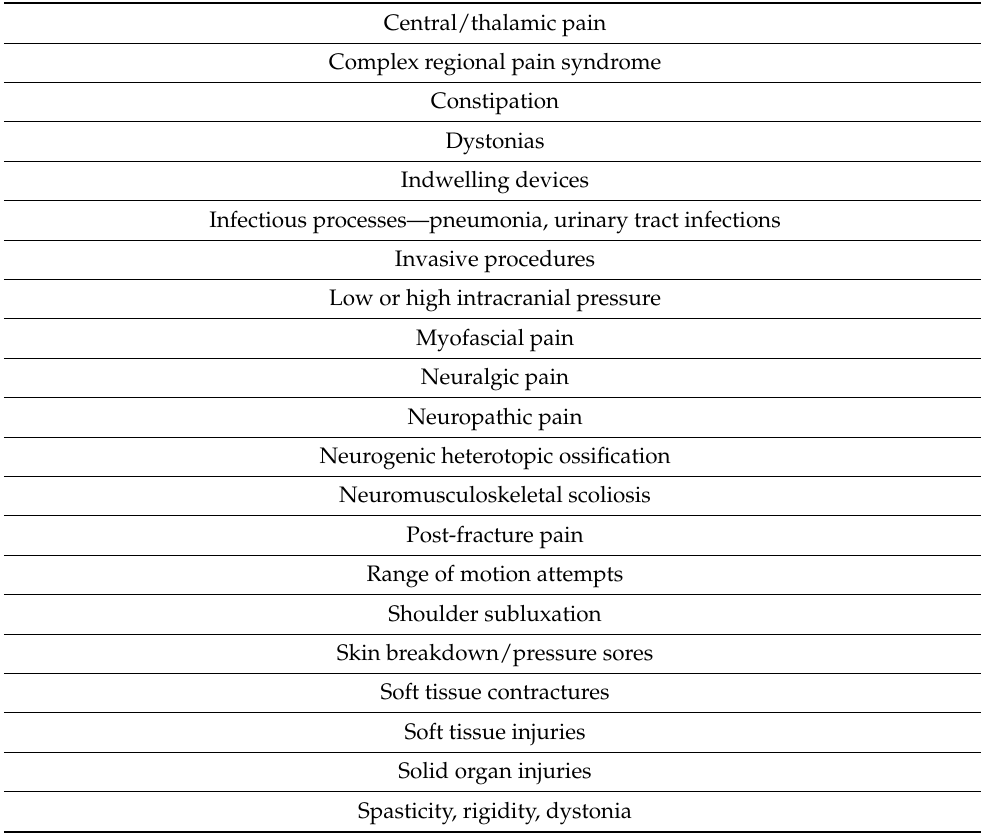
Table 1. Common Pain Generators in Persons with